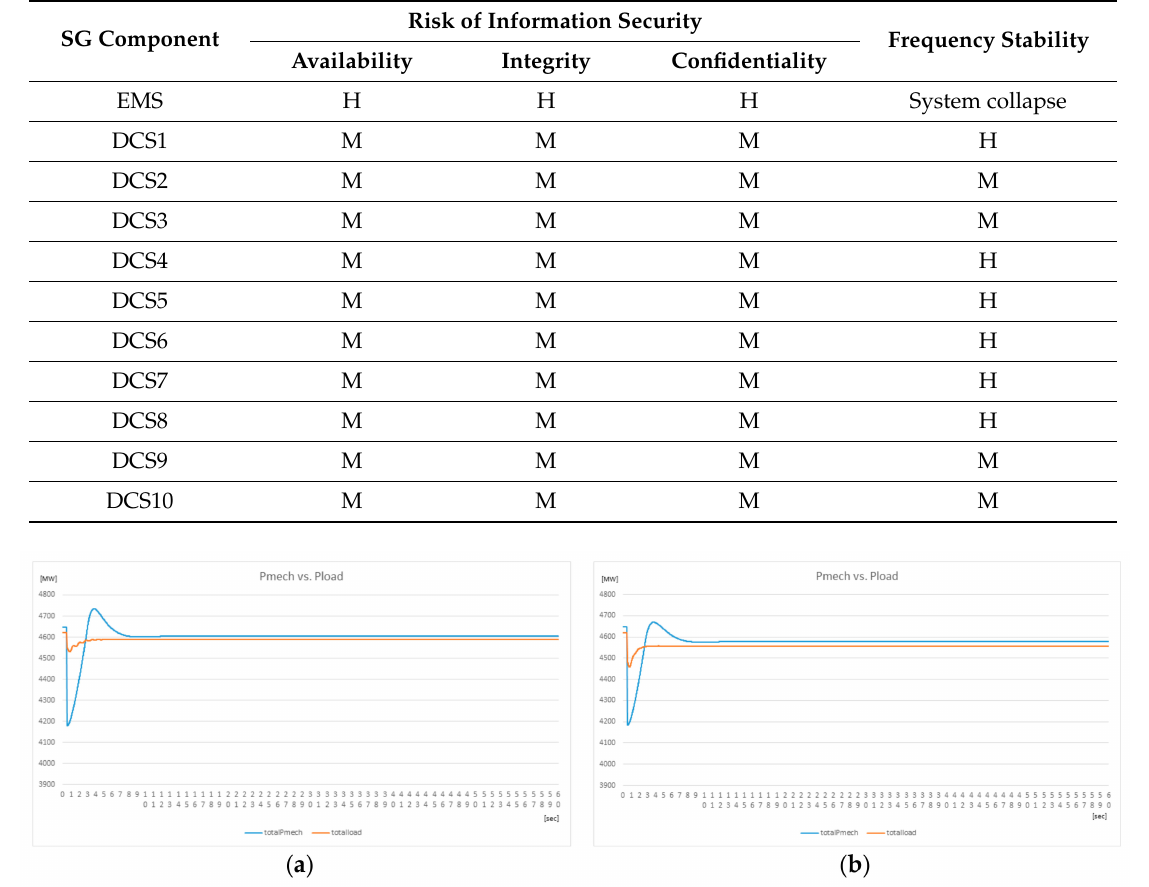
Figure 5. ( a ) The tripping of generator 1. ( b ) The tripping of generator